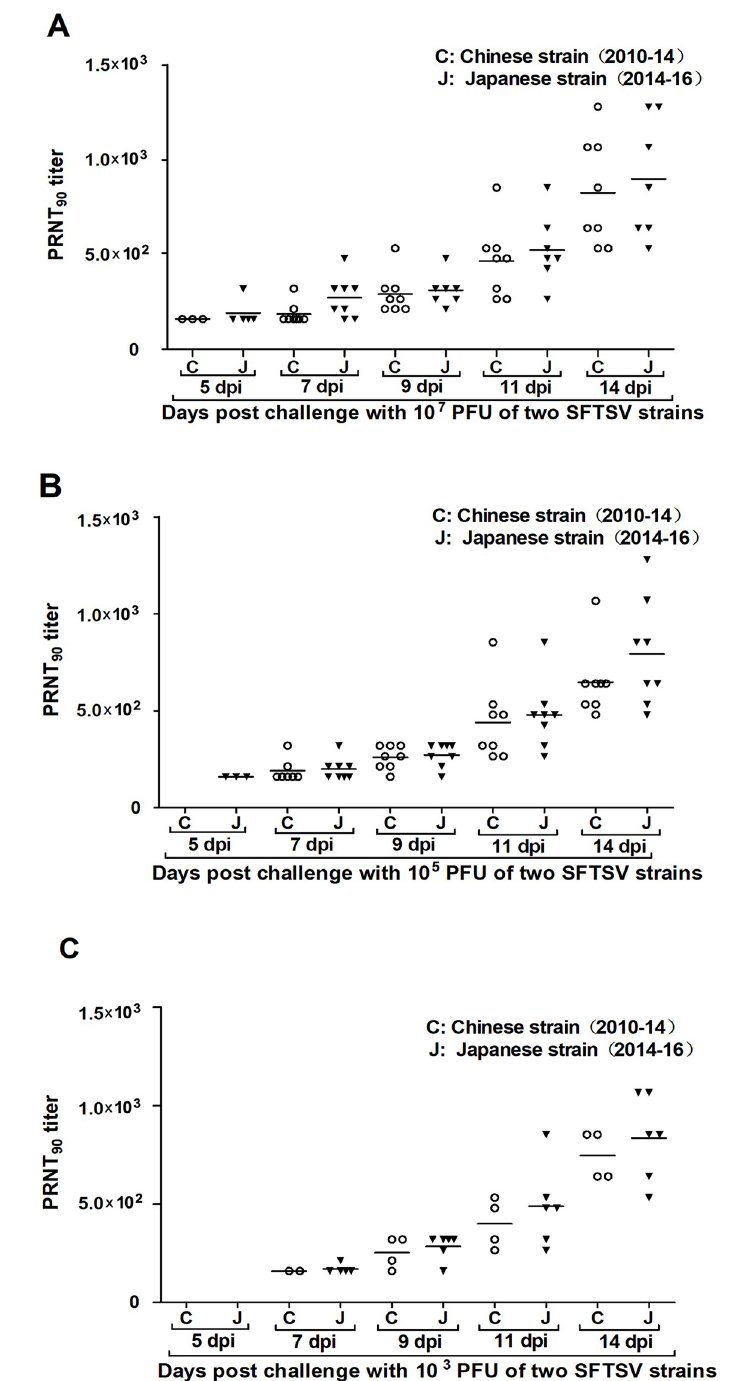
Fig 3. Neutralizing antibody titers in spotted doves infected with different challenge doses of two SFTSV strains. Spotted doves challenged with 10 7 and 10 5 PFU of SFTSV (A and B) showed earlier neutralizing antibody than 10 3 challenge groups